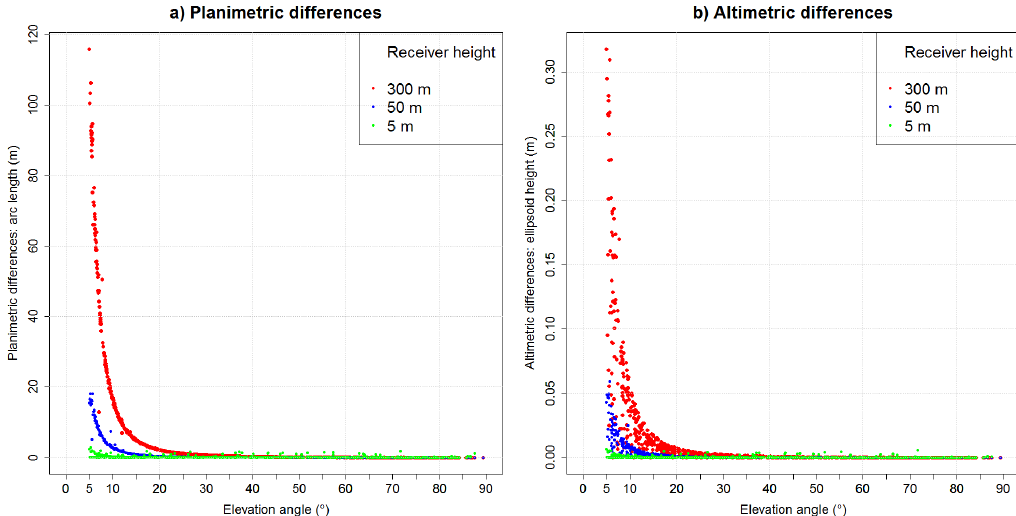
Figure 16. Angular refraction correction as a function of the satellite elevation angle and for different receiver heights above the reflecting surface. (a) Planimetric differences as arc length (m). (b) Altimetric differences as ellipsoid height